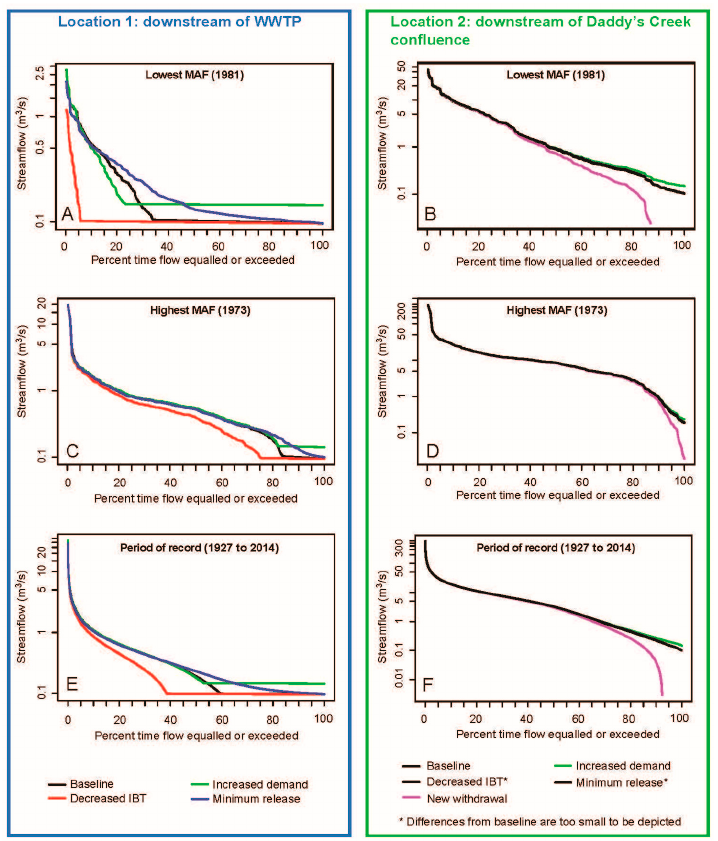
Figure 3. Flow-duration curves for modeled streamflow based on water-use scenarios for model Locations 1 (left) and 2 (right); see Figure 2C for model locations. Curves are presented for: ( A , B ) the year with the lowest MAF; ( C , D ) highest MAF; and ( E , F ) the entire period of record. The new